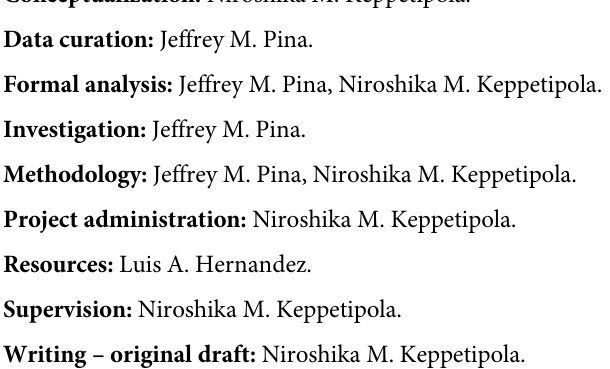
S4 Table. Common contaminants in mass spectrometry assays. A list of proteins considered common contaminants in mass spectrometry assays. S5 Table. Common co-purified proteins with PTBP1 and PTBP2. A list of proteins that co- purified with both PTBP1 and PTBP2 under in vitro splicing conditions containing HeLa nuclear extract. S6 Table. Distinct PTBP1 interacting proteins. A list of distinct proteins that co-purified with PTBP1 under in vitro splicing conditions containing HeLa nuclear extract. S7 Table. Distinct PTBP2 interacting proteins. A list of distinct proteins that co-purified with PTBP2 under in vitro splicing conditions containing HeLa nuclear